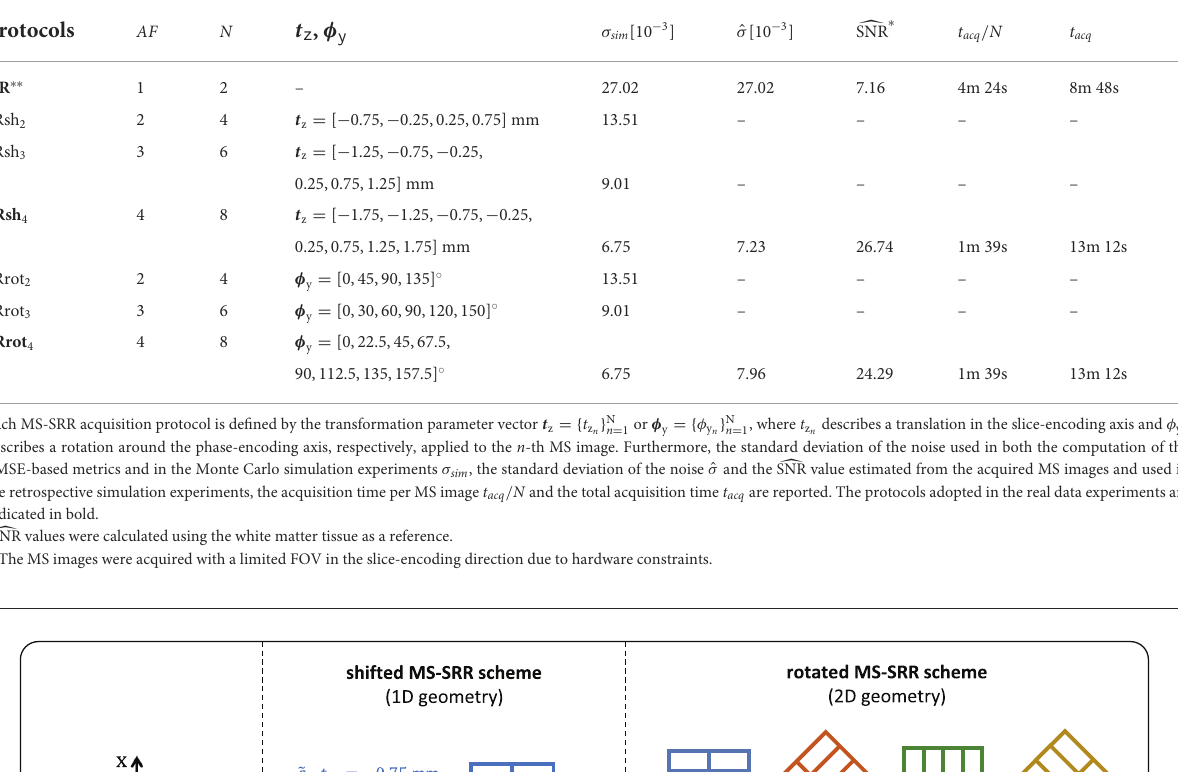
2, N 4, and res ip = =